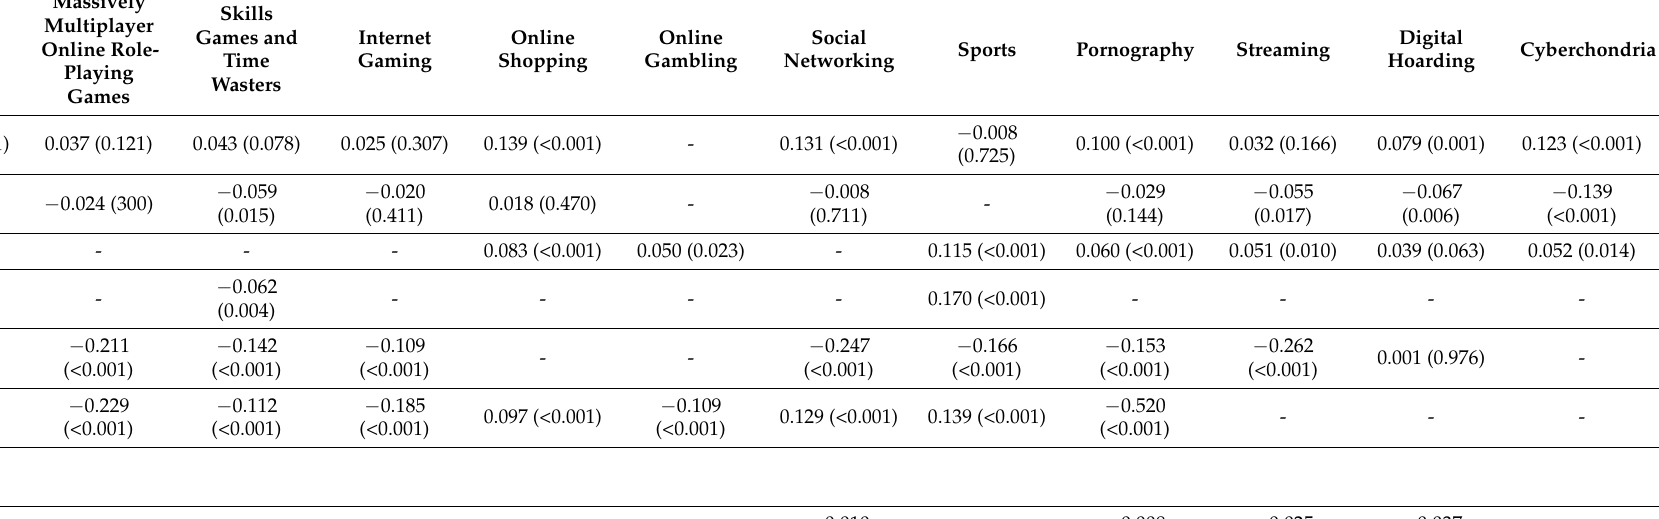
Table 3. Multivariable modelling, including self-reported internet activities and demographic, clinical, and psychological characteristics. Massively Multiplayer General Online Role- Surfing Playing